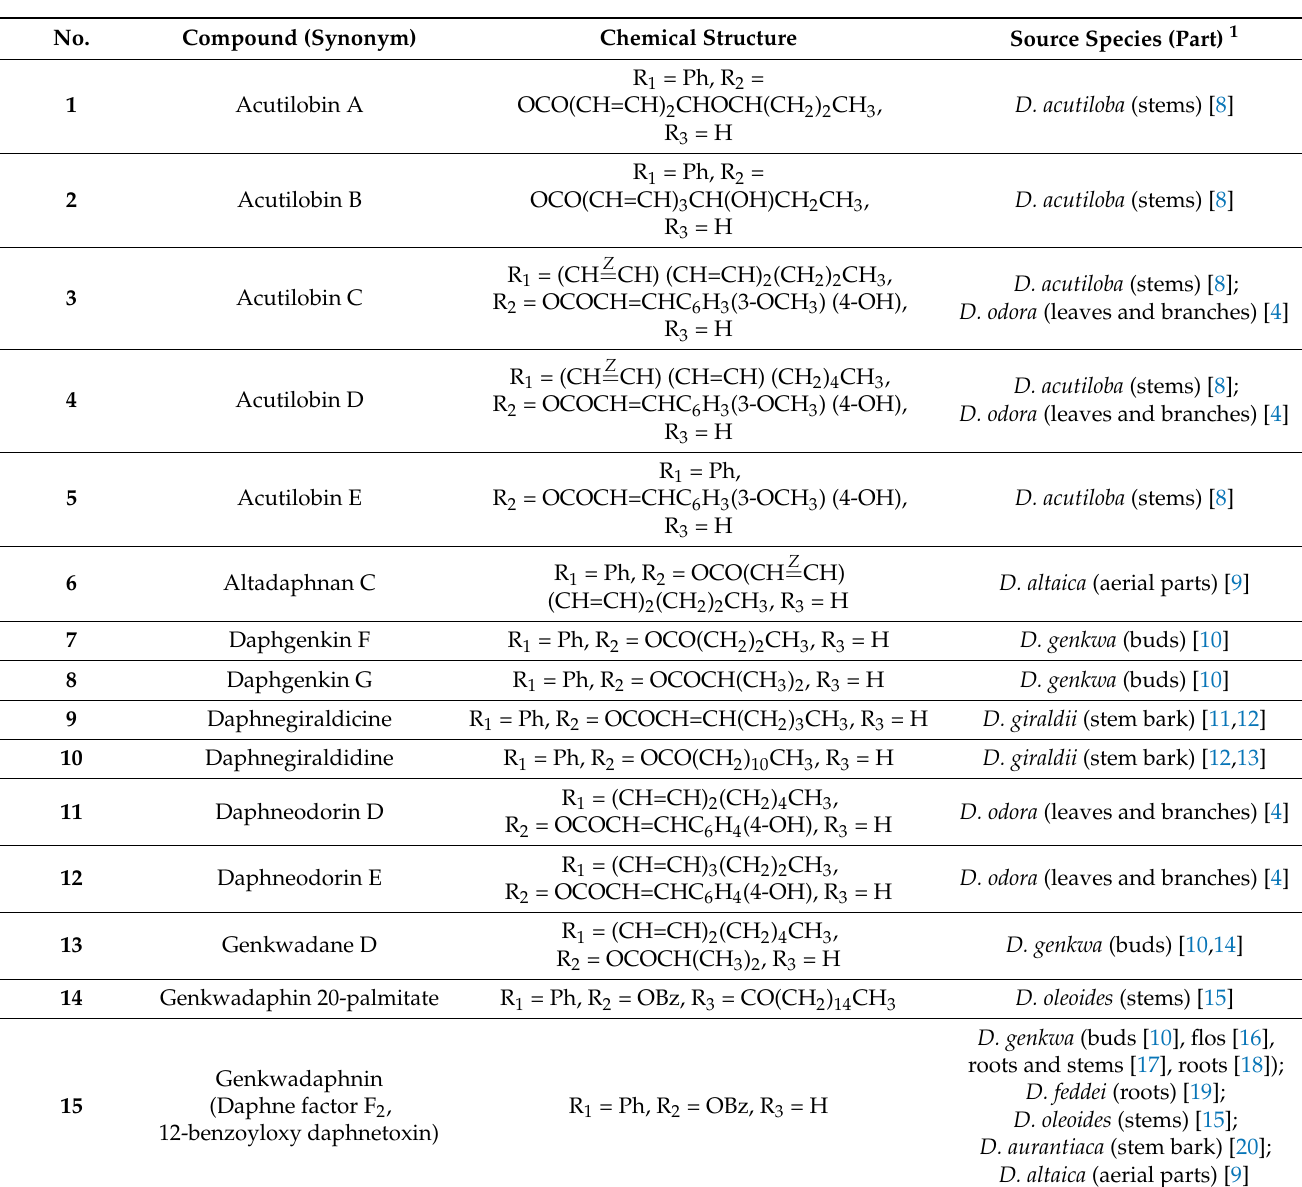
Figure 2. Structures of 12-hydroxydaphnetoxins ( 1 – 54 ). The species from the Thymelaeaceae are rich sources of 12-hydroxydaphnanetoxins, especially the genus Daphne . Compounds of this class were mainly isolated from D. genkwa , D. tangutica, and D. acutiloba and these diterpenoids were abundant in the flower buds of D. genkwa , stems, roots, and especially bark of the plants (Table 1). Table 1. Structures and sources of 12-hydroxydaphnetoxins ( 1 – 54